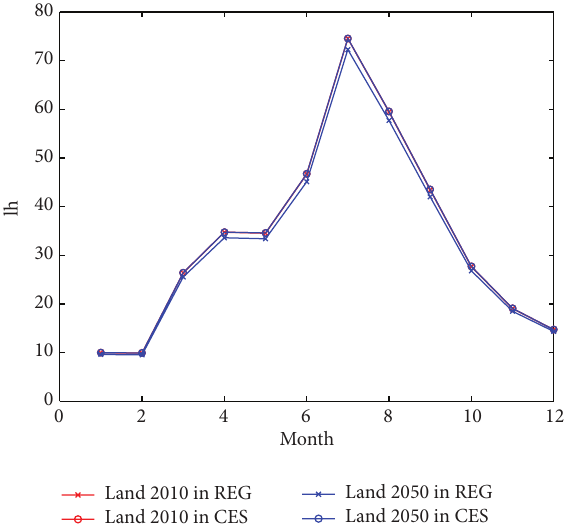
Figure 10: Comparison of the latent heat flux in Southern-Jiangsu under different scenarios (unit: W/m 2